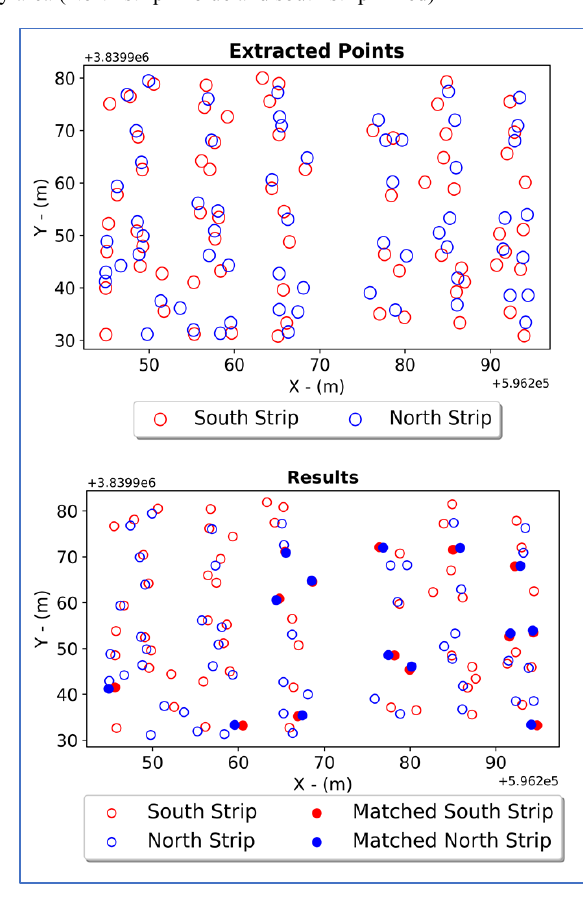
Figure 8. Test Plot II Results (top row: the extracted keypoints), (bottom row: the alignment results of the keypoints) were 0.21 m to 1 m. After horizontal alignment of strips, the vertical shift correction takes place. Figure 10 describes the result of planimetric and vertical alignment using a profile of the point cloud of the two test plots. It is visually noticed that for both plots, there is a parallelism between their ground level which indicates true alignment of their z-axes before and after the process of strip adjustment. The study area is a planted forest in which the trees within the same plot have the same characteristics (e.g. species, age, height, stem diameter etc.). Also, the stem distribution is regular over most test plots.